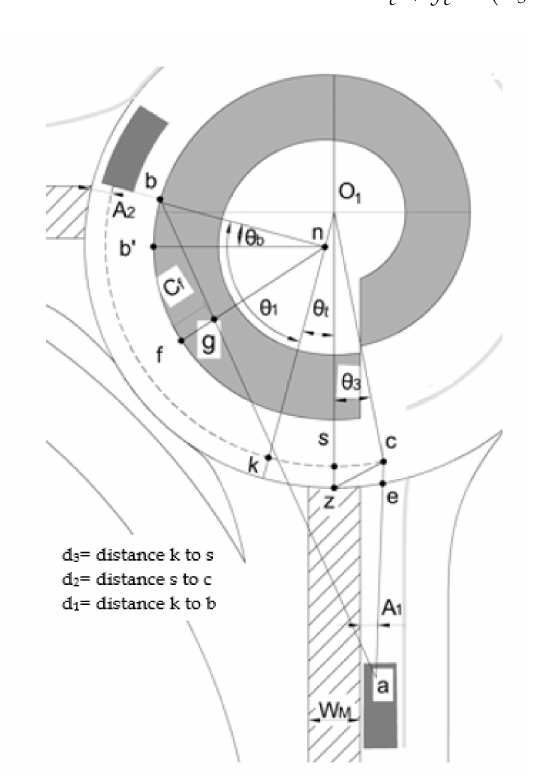
Figure 4. Geometry of ISD for the approaching and conflicting-circulating